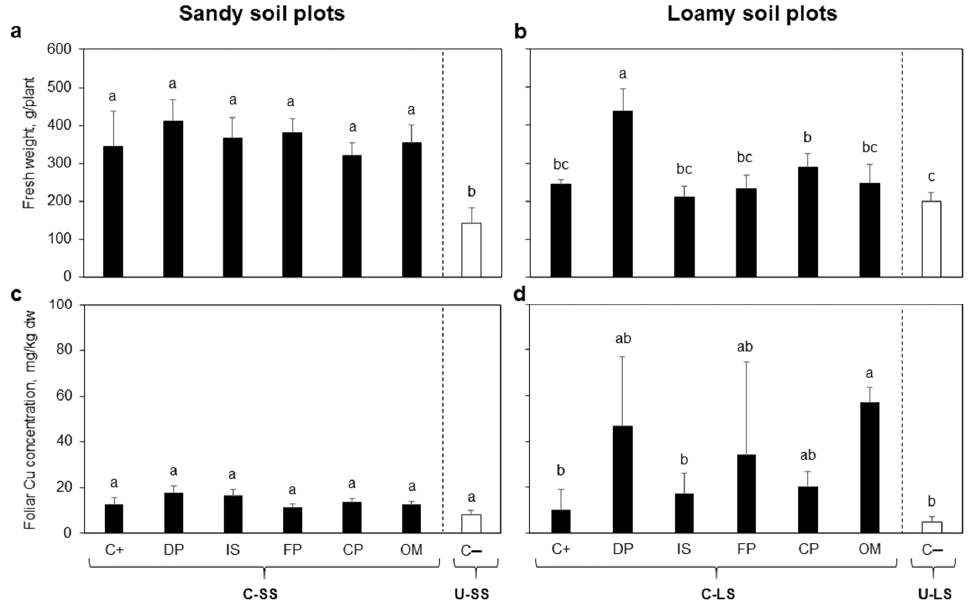
Figure 3. Fresh weight of lettuces at harvest time and the corresponding copper concentration in their edible tissues (on a dry weight basis): ( a , c ) are the results of lettuces grown on sandy soils, while ( b , d ) are those for lettuce grown on loamy soils. Bars are means ± SD ( n = 5). Different letters above the means indicate significant differences between treatments based on Tukey multiple comparison test ( p ≤ 0.05). Black bars represent contaminated soil under different treatments: C+ = Contaminated soil without amendment; DP = diammonium phosphate; FP = ferrous phosphate; IS = iron sulfate; OM = organic matter addition; CP= calcium peroxide. White bar represents uncontaminated soil: C − = Uncontaminated soil without amendment. C-SS = Contaminated sandy soil plot; U-SS = Uncontaminated sandy soil plot; C-LS = contaminated loamy soil plot; and U-LS = Uncontaminated loamy soil plot.